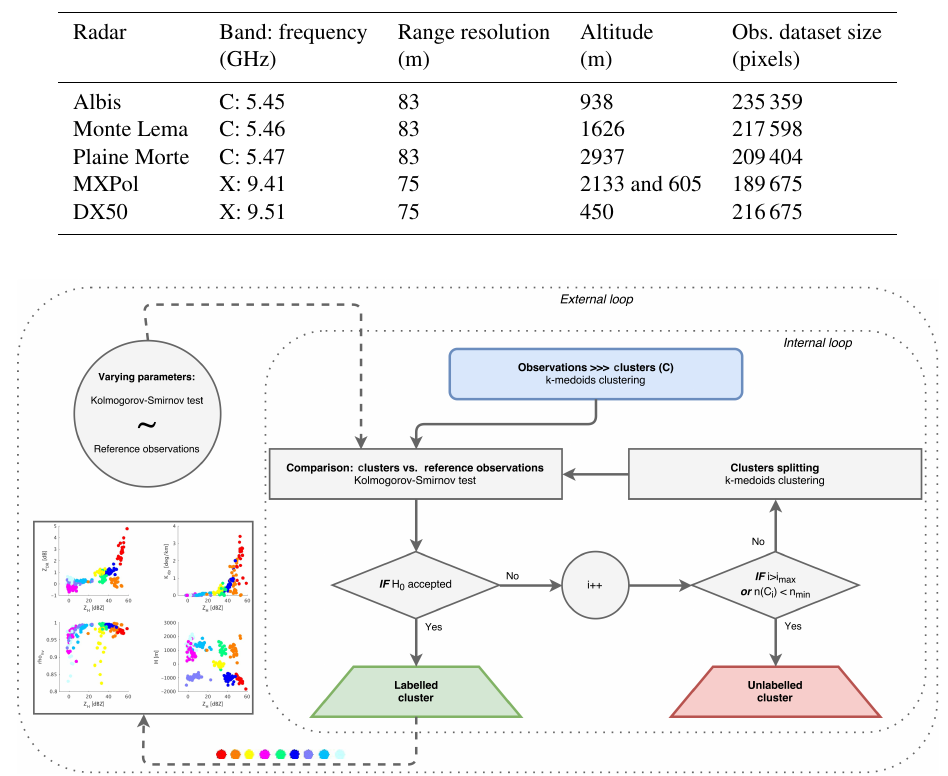
Table 1. Basic information about the four observations datasets.